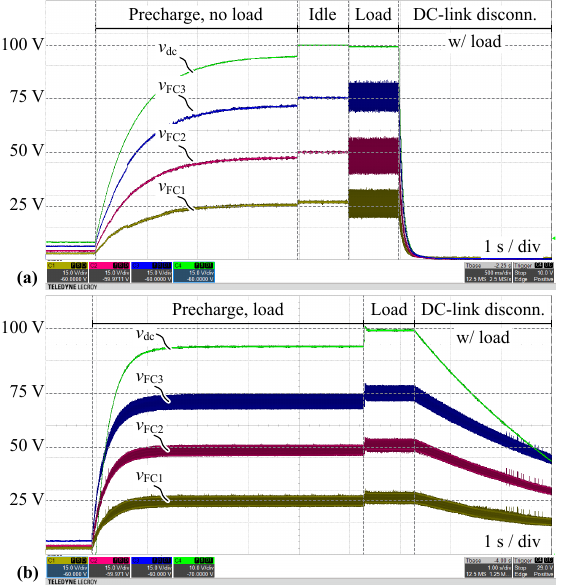
Figure 21. Measured waveforms (DC-link capacitor voltage v dc , FC voltages v FC{1,2,3} ) for start-up (precharging) and shut-down of Q2L-5L-FCC: ( a ) Full DC-link configuration with resistive balancers (precharge → idle → nominal load → DC-link voltage disconnection under load). ( b ) Split DC- link configuration without resistive balancers (precharge under load → nominal load → DC-link voltage disconnection under load). Note the different time bases due to the different DC-link capacitance